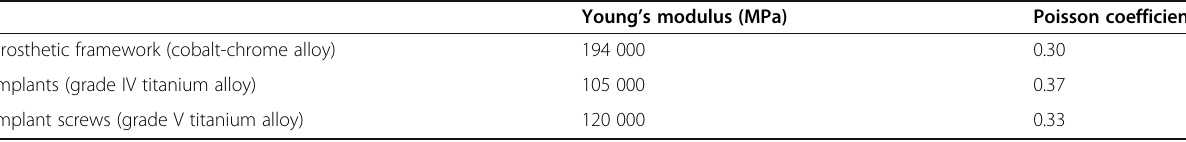
Table 2 Materials and elastic properties defined for implants, implant screws and prosthetic